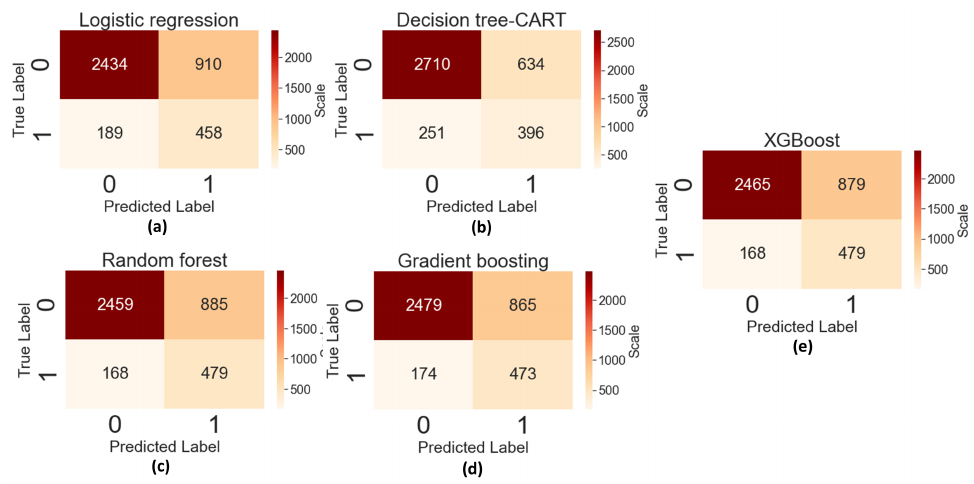
Figure 7. Confusion matrix of the studied models. ( a ) Logistic regression. ( b ) Decision tree-CART. ( c ) Random forest. ( d ) Gradient boosting. ( e )